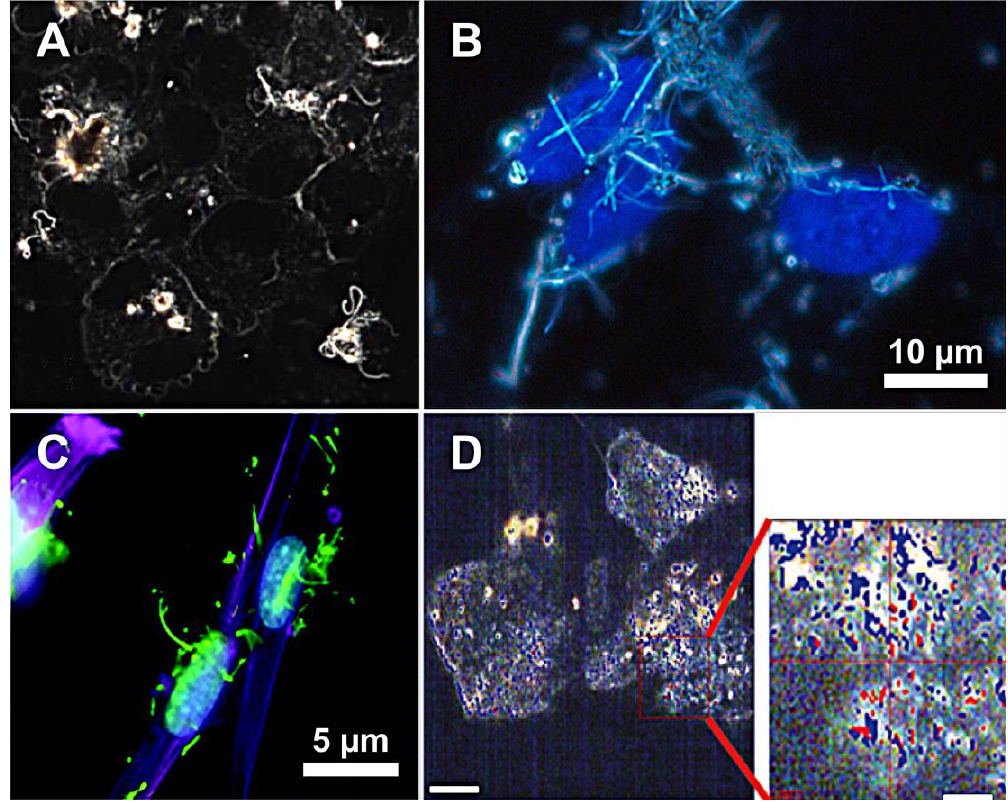
Figure 3. ( A ) Dark-field image of RAW 264.7 macrophages exposed to MWCNTs (0.2 µg/cm 2 ) for 24 h. ( B ) Composite image of enhanced dark-field showing the MWCNT fibres in the white and blue fluorescent DAPI stained nuclei of BEAS-2B cells after 24 h of exposure. ( C ) Fluorescence-enhanced dark-field microscopy images of MRC-5 cells exposed to 10 µg/mL of MWCNTs for 24 h. Magenta colour shows F-actin (cytoskeleton), blue colour represents DNA (cell nuclei), and green colour shows MWCNTs. ( D ) Hyperspectral mapping of SAECs co-treated with SWCNTs (blue pixels) and pandemic H1N1 influenza A virus (red pixels). Figure 3A adapted from Ref. [64] under the terms of the Creative Commons Attrib- ution License (CC-BY 3.0), scale not specified. Figure 3B adapted from Ref. [76] under the terms of the Creative Commons Attribution License (CC-BY 4.0). Figure 3C adapted from Ref. [67] under the terms of the Creative Commons Attribution License (CC-BY 4.0). Figure 3D adapted from Ref. [78] under the terms of the Creative Commons Attribution License (CC- BY 4.0), scale not specified.